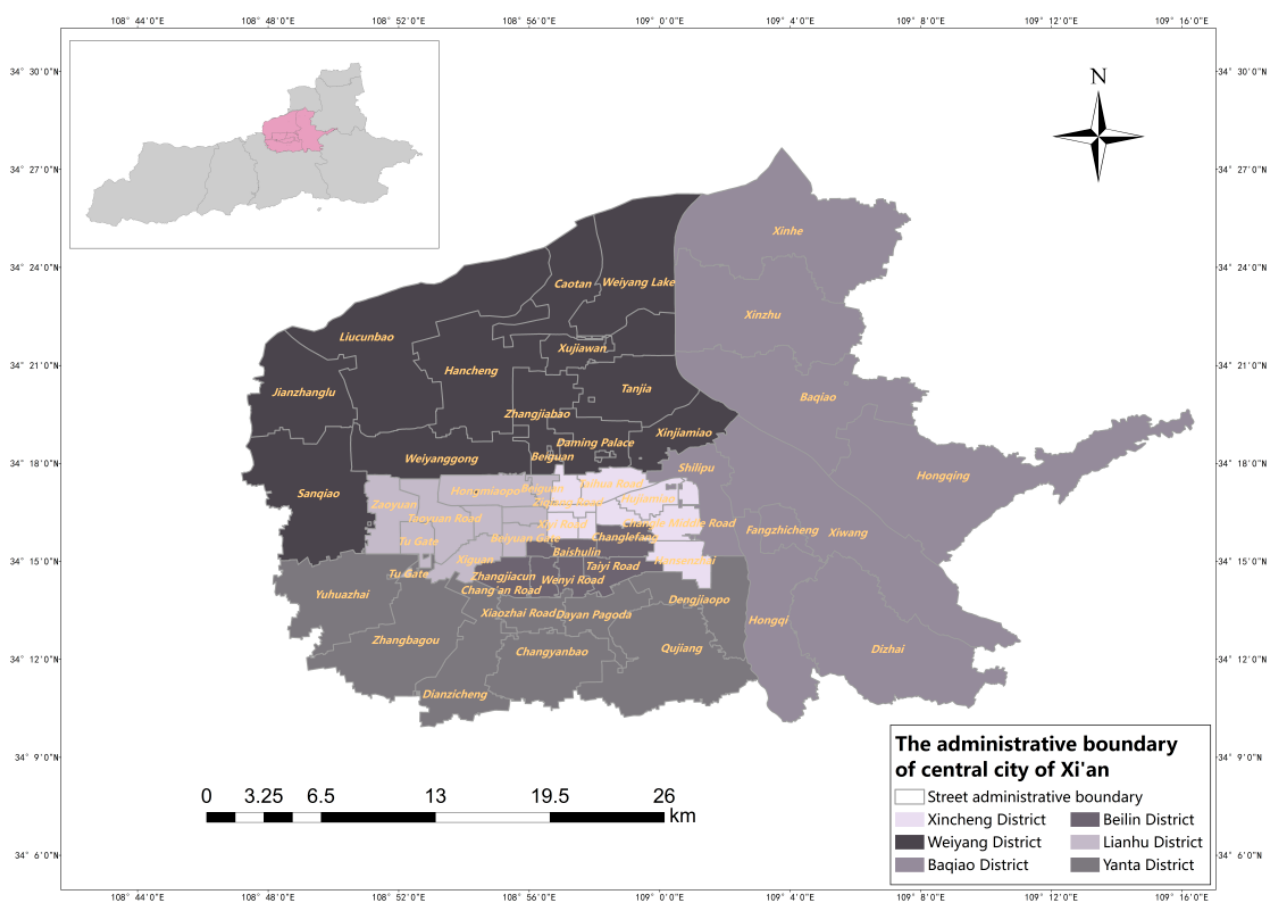
Figure 1. The administrative boundary of central city of Xi’an.